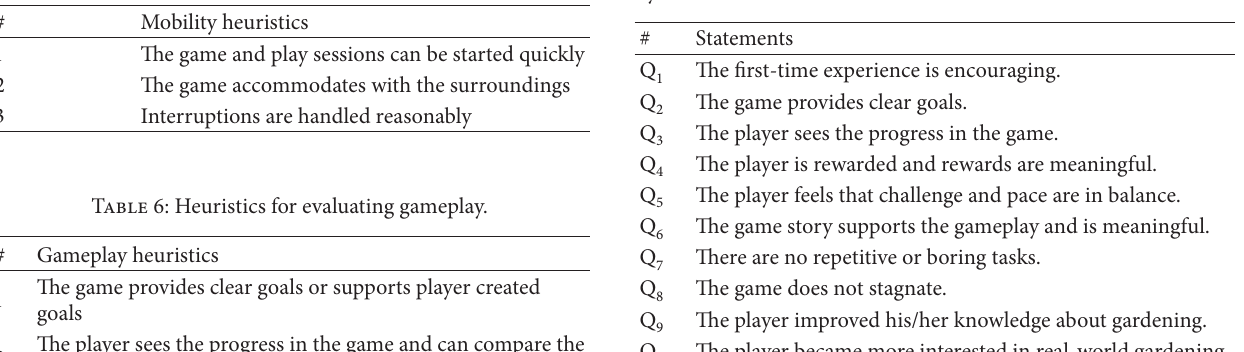
Table 5: Heuristics for evaluating mobility.